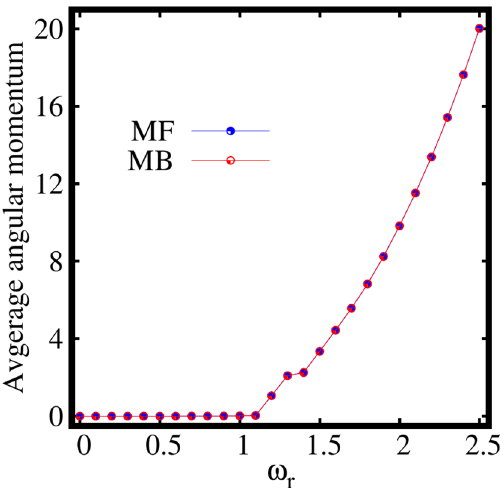
Figure 8. Expectation value of angular momentum operator �ˆ L Z � / N , computed at the mean-field (MF) and many-body (MB) levels [with M = 1 and M = 3 self-consistent orbitals, respectively] as a function of the rotation frequency ω r for the three-fold symmetric trap. All quantities shown are dimensionless.